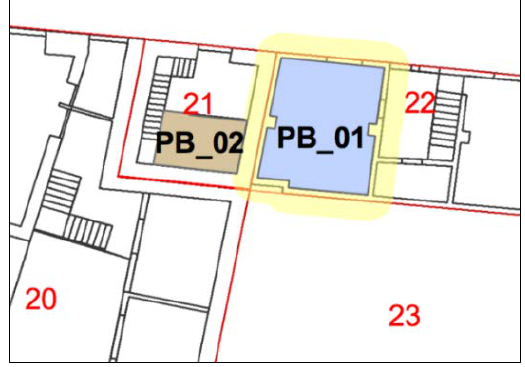
Figure 4: Damage in various elements in continuous environments. Source: vlirCPM